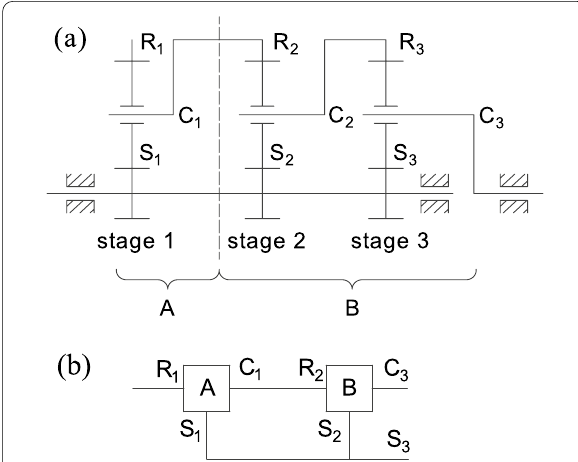
Figure 1 Three‑stage PGT consisting of two parallel‑connected Wilson transmissions: a Functional diagram, b General model representation